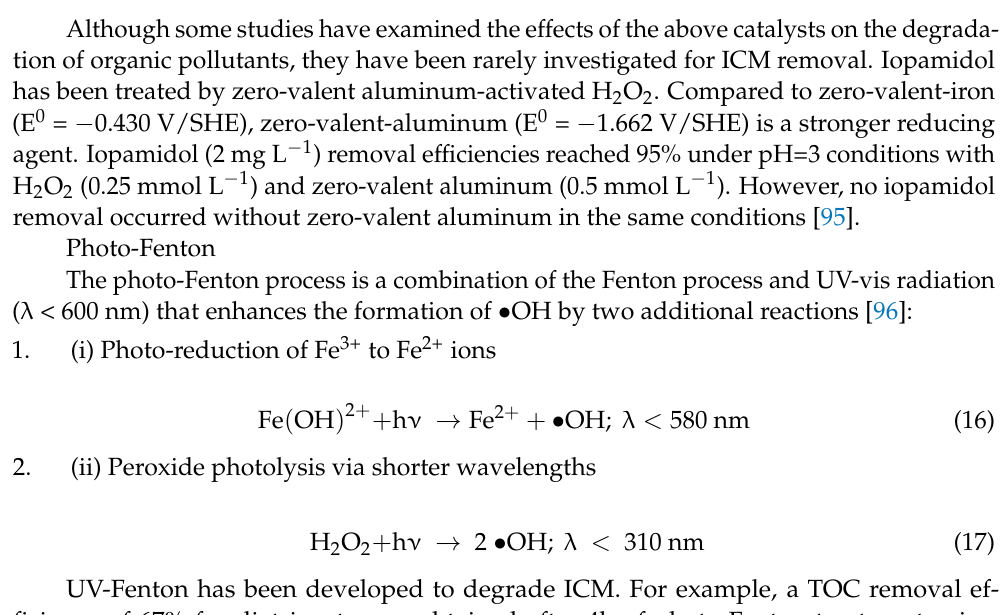
Figure 4. Schematic illustration of H 2 O 2 activation mechanisms using different nonferrous Fenton- type reagents [94] . Reprinted from ref [94] , Copyright 2014, with permission from Elsevier.